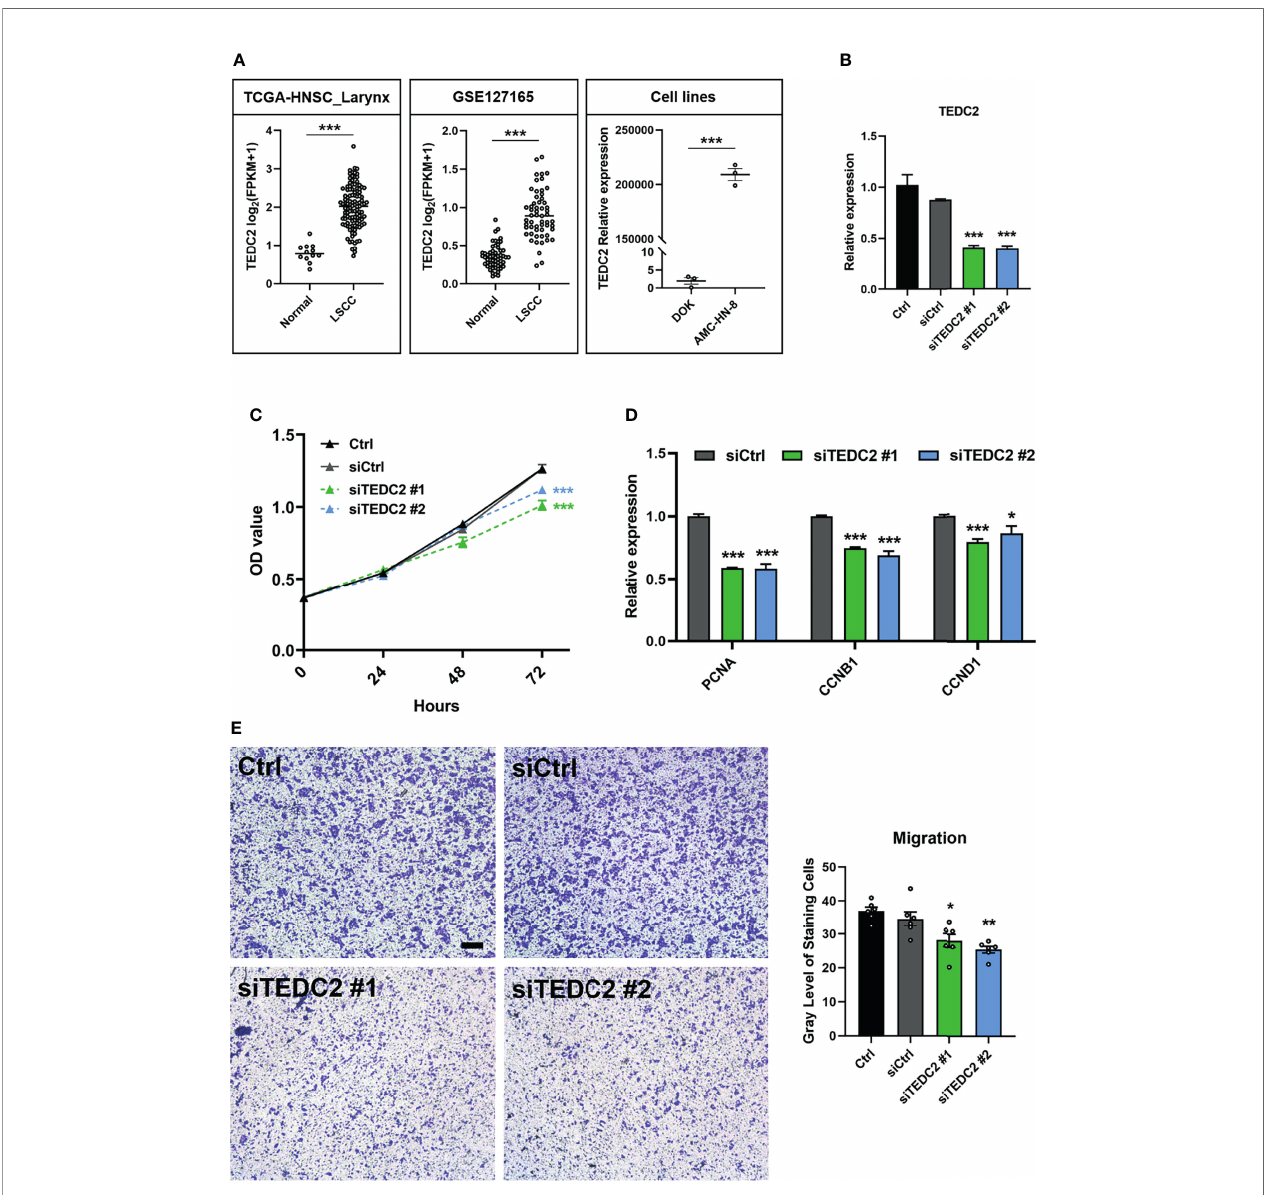
FIGURE 8 | TEDC2 affects tumor cell proliferation and migration. (A) Expression pro fi le of TEDC2 between normal and LSCC samples in the TCGA-HNSC- Larynx dataset (left) and GSE127165 (middle). TEDC2 expression between laryngeal cancer cell line AMC-HN-8 and dysplastic oral keratinocyte cell line DOK (right). (B) AMC-HN-8 cells were transfected with siRNAs targeting TEDC2 (siTEDC2 #1 and siTEDC2 #2) or normal control siRNAs (siCtrl) for 48 h. The expression of TEDC2 was examined by RT-PCR. (C) AMC-HN-8 cells were transfected with siRNAs targeting TEDC2 (siTEDC2 #1 and siTEDC2 #2) or normal control siRNAs (siCtrl), then cell proliferation was determined by CCK-8 assay. (D) Expressions of PCNA , CCNB1 , and CCND1 were examined by RT-PCR. (E) The migration abilities of AMC-HN-8 cells after transfected with siRNAs targeting TEDC2 (siTEDC2 #1 and siTEDC2 #2) or normal control siRNAs (siCtrl) were detected by transwell assays. Bar, 200 m m. Error bars represent SEM of at least three independent experiments; * p < 0.05; ** p < 0.01; *** p <